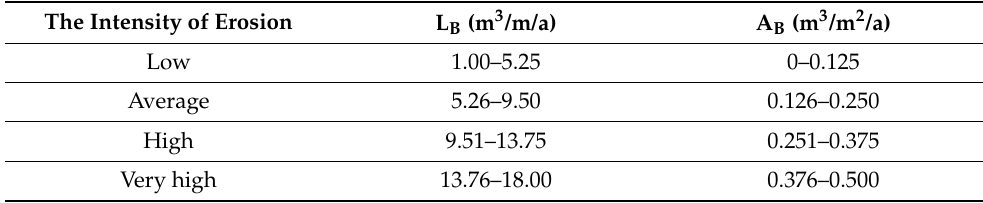
Table 3. Sediment loss categories (Source: this